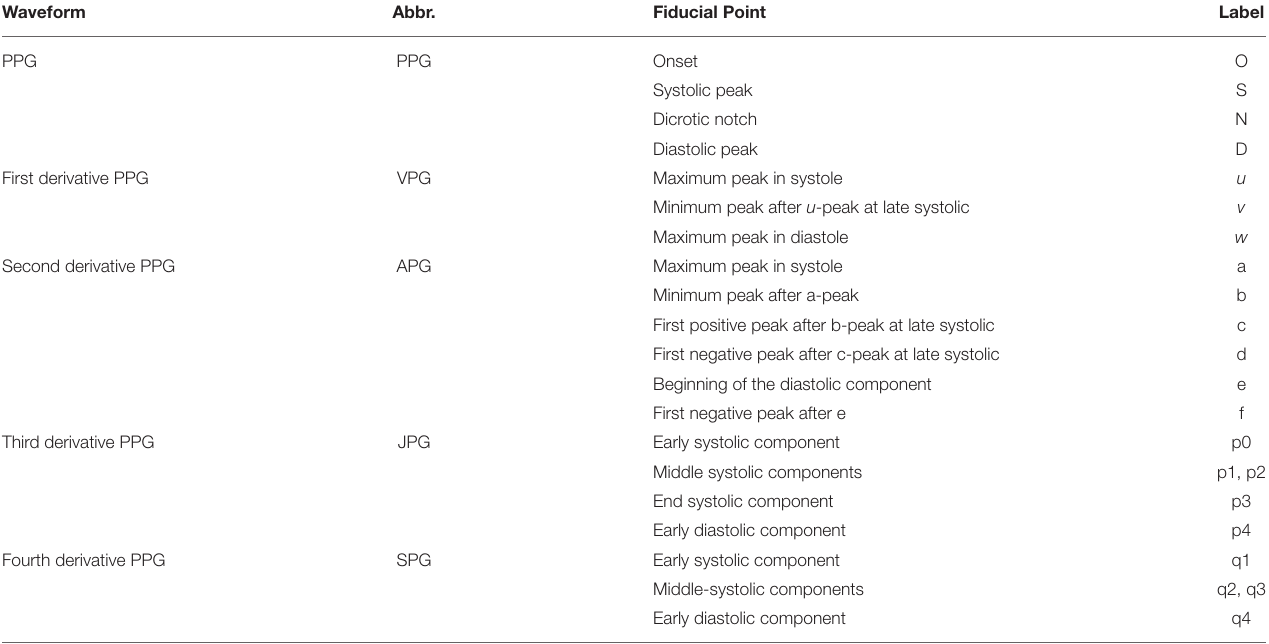
TABLE 2 | Fiducial points of PPG and its derivatives.